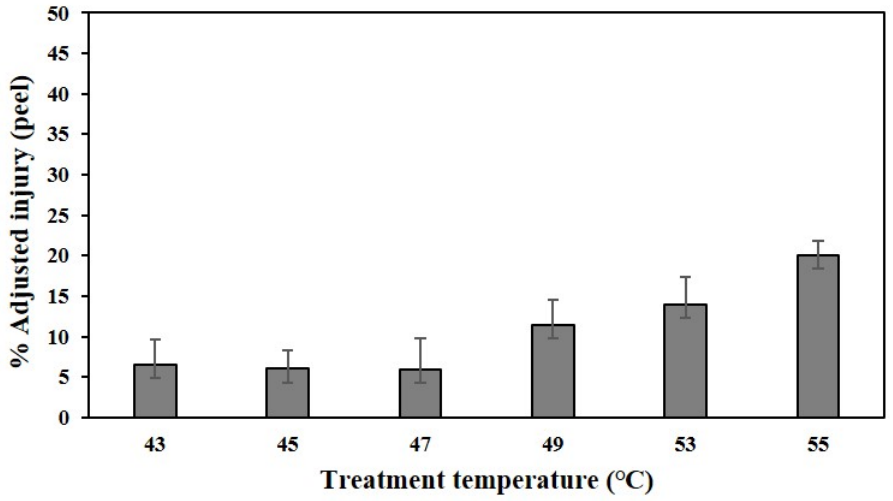
Figure 8. The percentage of adjusted injury on peels of Satsuma mandarin fruits subjected to soaking treatments at different water temperatures. The data are expressed as mean ± SE ( n = 5).